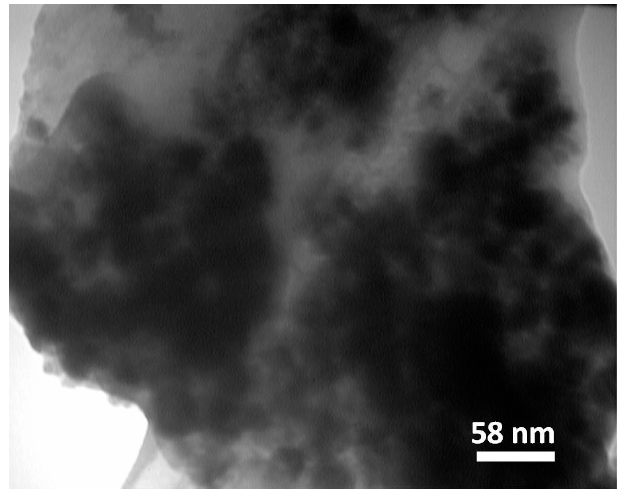
Figure 7. TEM image of reused GO/Fe 3 O 4 / L -pro nano hybrid after eight runs.